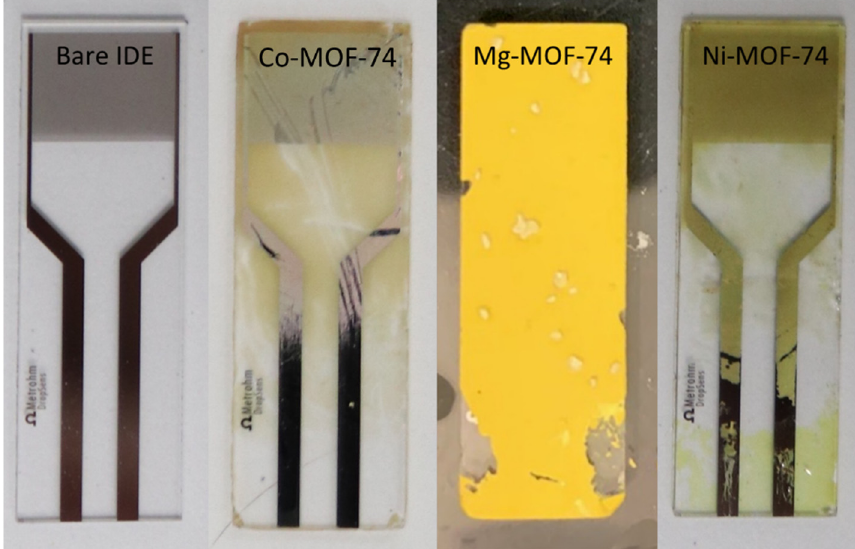
Figure 2. Photographs of the bare IDE with no MOF growth, IDE with Co-MOF-74 thin film, IDE with Ni-MOF-74 thin film and IDE with Mg-MOF-74 thin film. IDEs are 22.8 × 7.6 mm. Mg-MOF-74 is shown prior to mechanically removing the bottom region before electrical measurements.